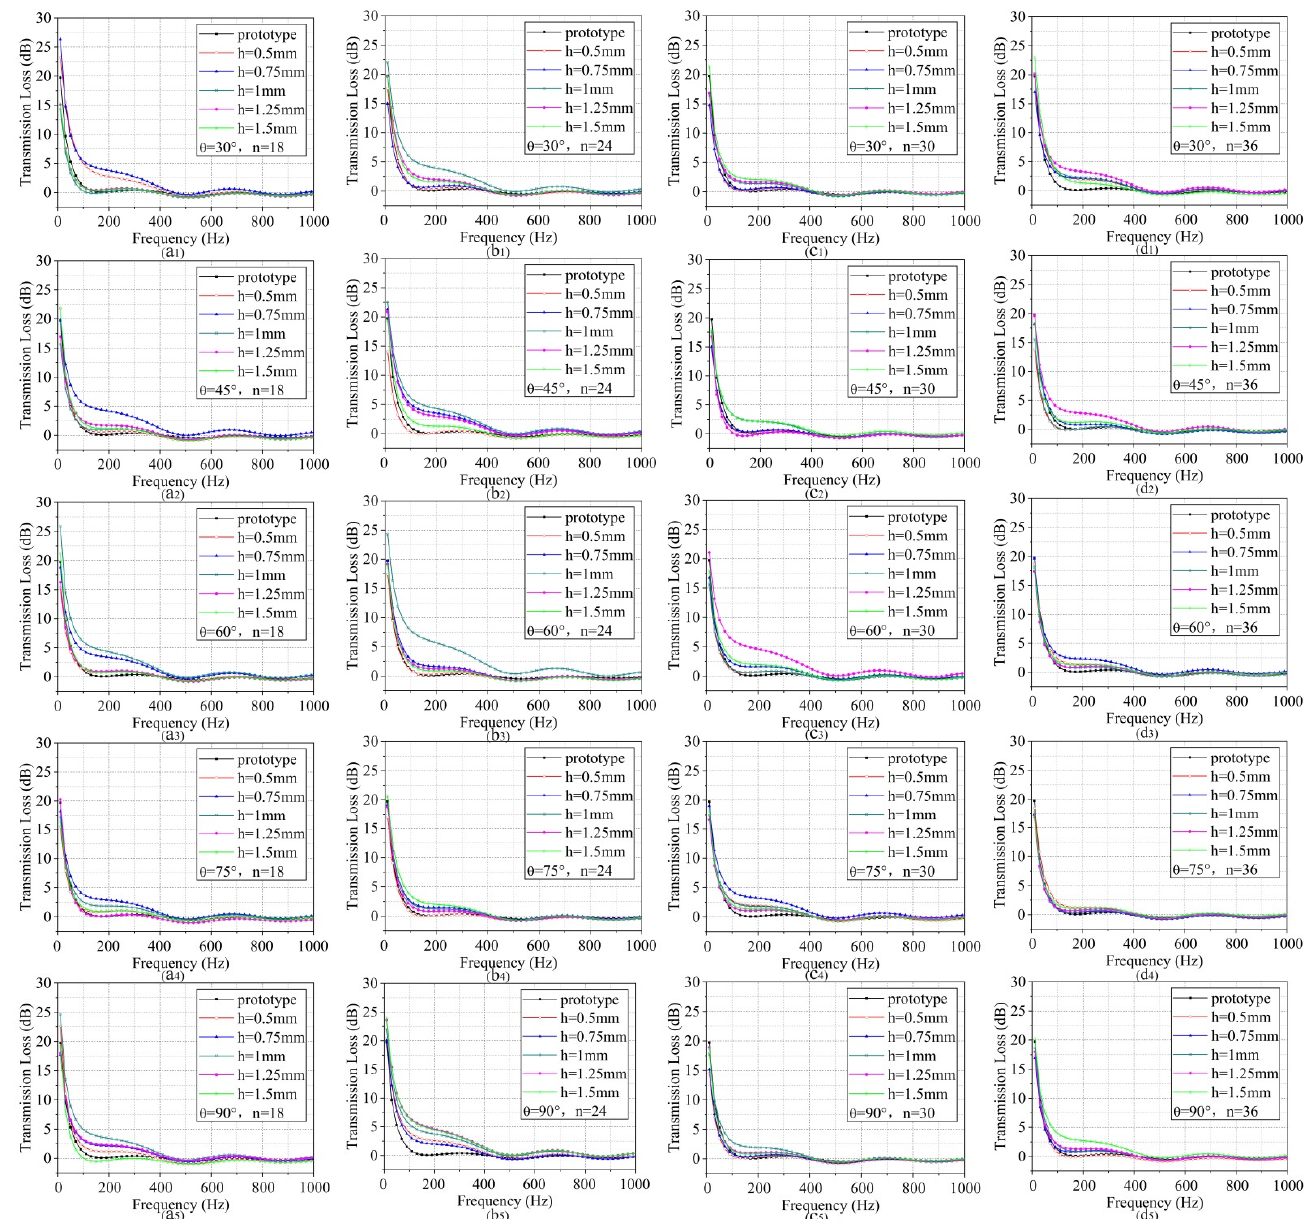
Figure 10. Transmission loss curves at different size parameters: ( a 1 – a 5 ) texture height h 0.5–1.5 mm, top angle θ 30 ◦ –90 ◦ and the number of circumferential columns n is 18, ( b 1 – b 5 ) texture height h 0.5–1.5 mm, top angle θ 30 ◦ –90 ◦ and the number of circumferential columns n is 24, ( c 1 – c 5 ) texture height h 0.5–1.5 mm, top angle θ 30 ◦ –90 ◦ and the number of circumferential columns n is 30, ( d 1 – d 5 ) texture height h 0.5–1.5 mm, top angle θ 30 ◦ –90 ◦ and the number of circumferential columns n is